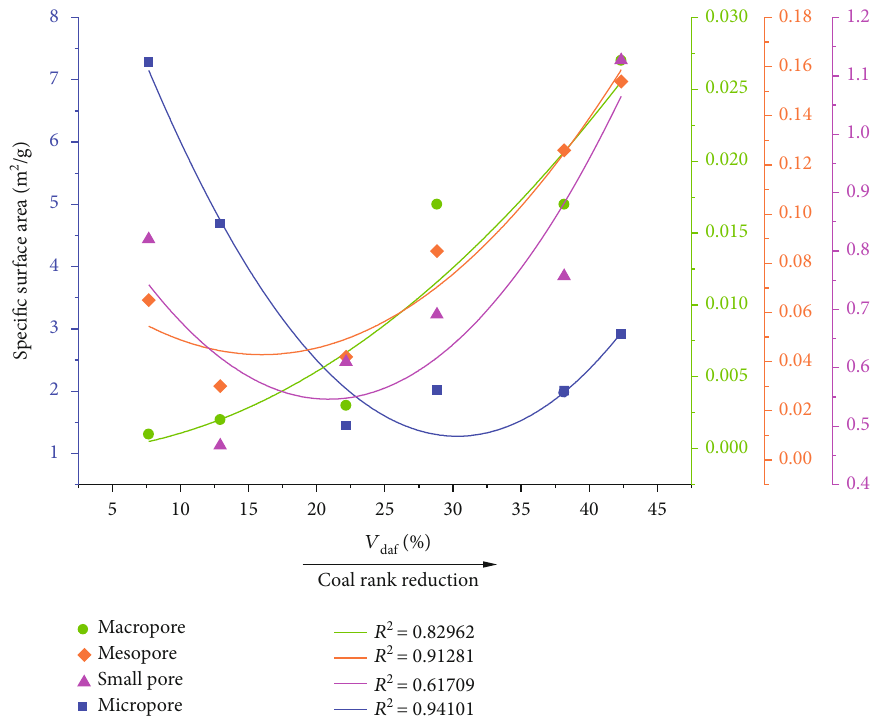
Figure 12: Curve of fi tting between volatile matter and pore speci fi c surface